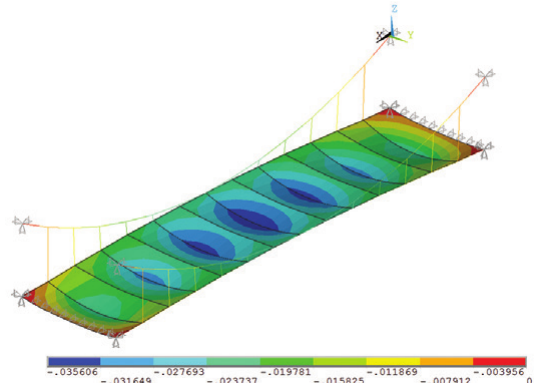
Fig. 12. Results of displacements and appearance of local effects of numerical model of the structure, where plywood boards are placed without the clearances and the deck behaves in compression and in bending Table 2. Results of experimental model testing and numerical simulation Displacement of point,